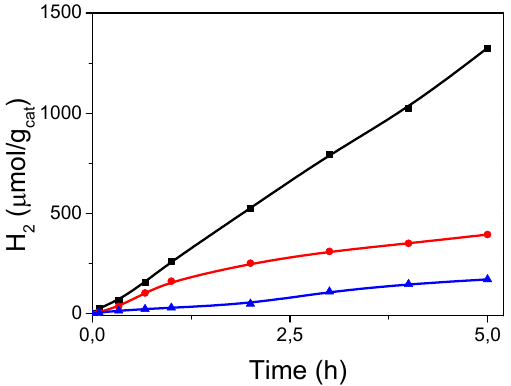
Figure 3. UV–Vis light driven hydrogen generation of (TBA) 2 [Mo 6 I i8 (O 2 CCH 3 ) a6 ] in aqueous solution containing TEA, water in 50% (black line), 40% (red line), and 30% (blue line) v / v and acetone.